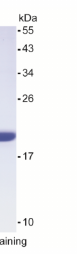
Figure 3. SDS-PAGE ( A ) and immunoblot ( B ) analysis of purified PGRP1. The purified recombinant PGRP1 was separated by 15% SDS-PAGE followed by Coomassie Brilliant Blue staining (lane 1, 3 µ g) or immunoblotting (lane 2, 0.6 µ g) with mouse monoclonal anti-polyhistidines as primary antibodies. The sizes and positions of the molecular weight standards are indicated on the